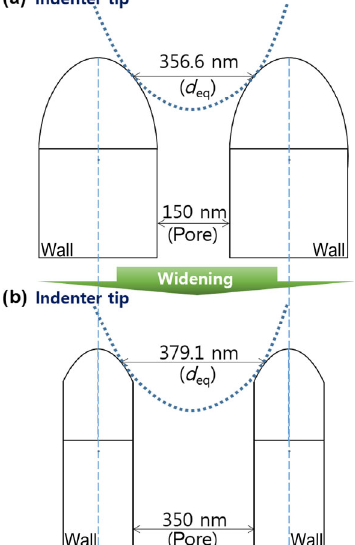
Fig. 7 Schematic presentation of the equivalent diameter of the porous area ( d eq ). (a) d eq of 150 nm metallic porous nanostructure and (b) d eq of 350 nm metallic porous